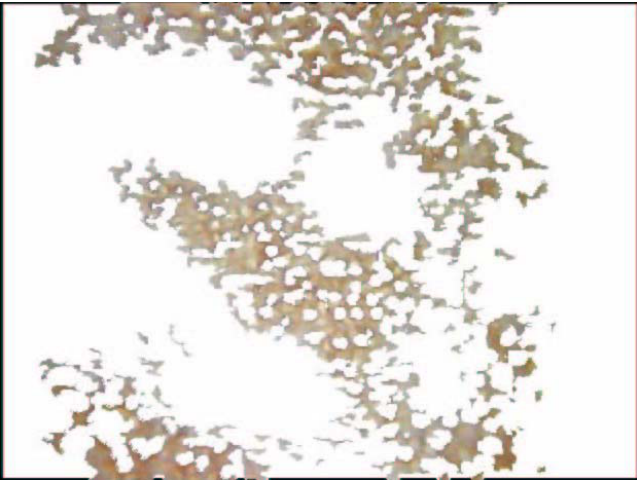
Fig. 8 Spatial visualisation of bcl-2 protein presented in Figure 7.